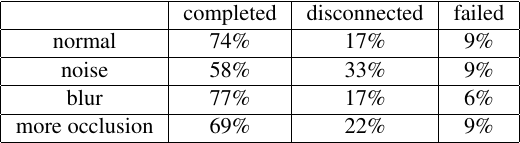
Table 1: Results of the single-camera tracking scenario. 35 per- sons were analyzed. ”Completed” are persons that were tracked correctly. ”Disconnected” indicates that the track was predomi- nantly correct, but was lost at one point and a new representation of the person was created. ”Failed” represents the number of per- sons that could not be tracked correctly.